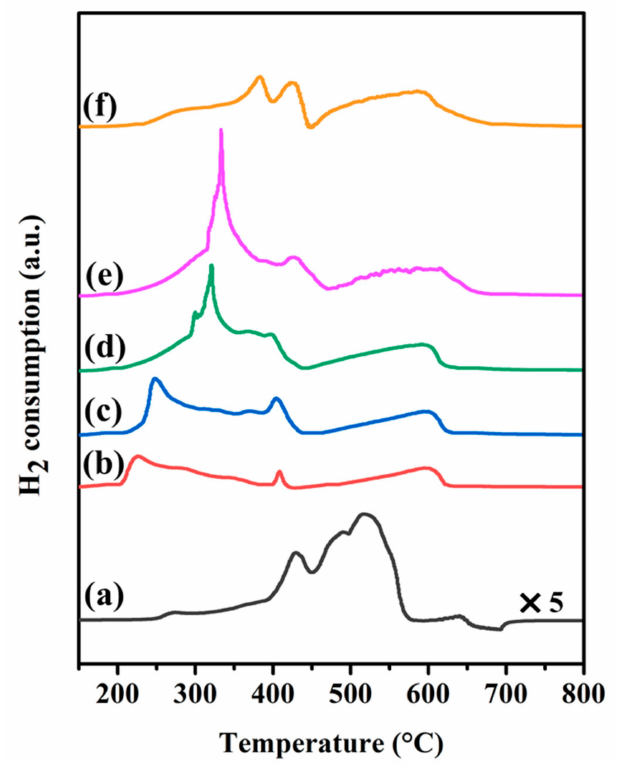
Figure 1. H 2 -temperature programmed reduction (H 2 -TPR) profiles of calcined (a) Cu/CaO, (b) Co 0.49 Cu 1 /CaO, (c) Co 0.96 Cu 1 /CaO, (d) Co 1.40 Cu 1 /CaO, (e) Co 1.94 Cu 1 /CaO, and (f) Co/CaO